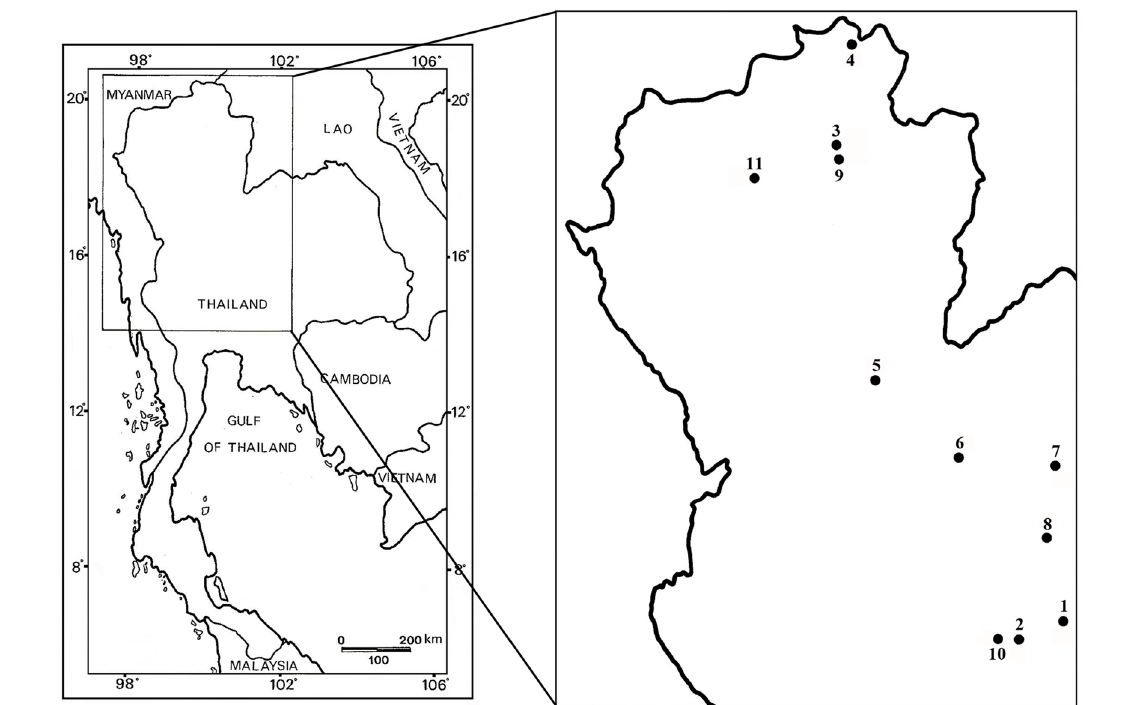
Fig. 20. Sampling localities of species of Siamopsis gen. nov. (for information on locality numbers, see the